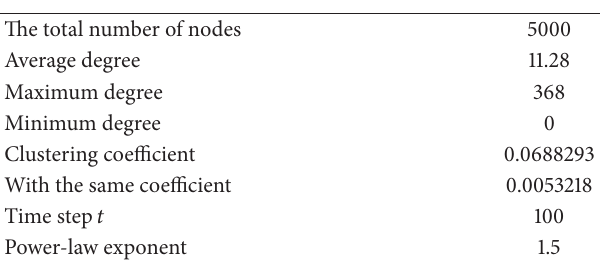
Table 1: Parameters of BA network.